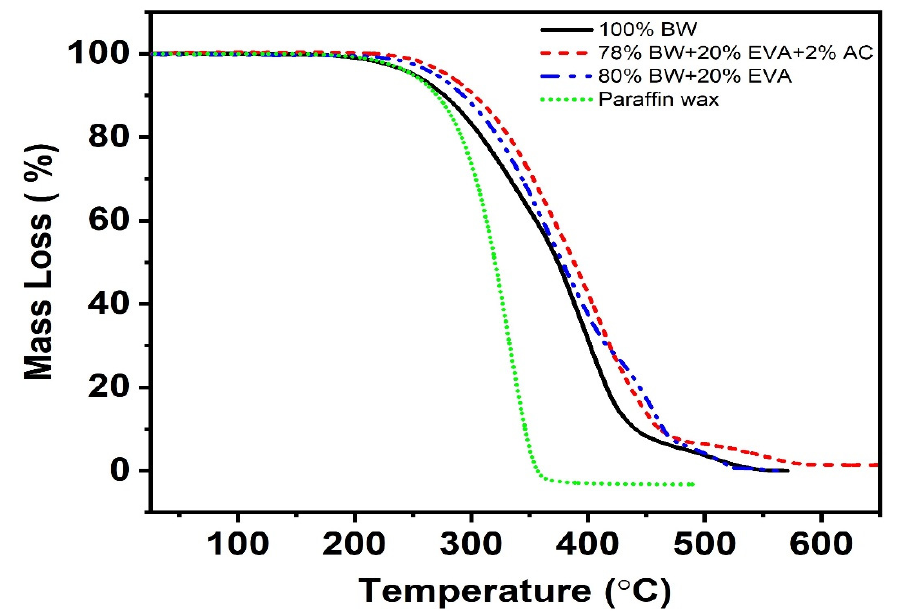
Figure 7. TG curves of BW–EVA-based solid fuels.